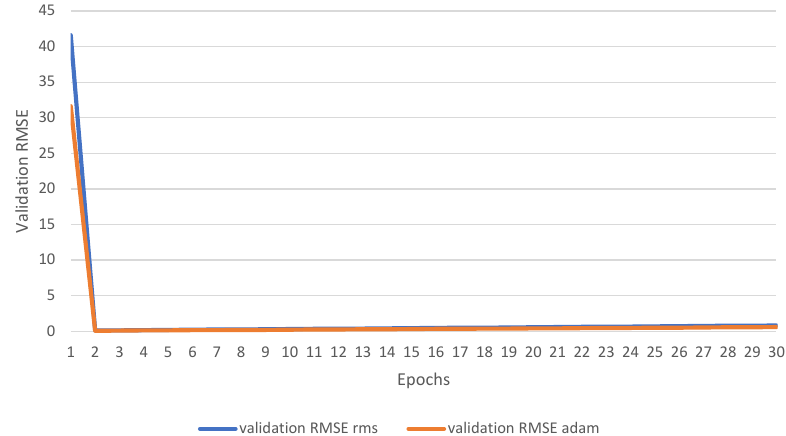
Figure 11. The proposed DCRN validation RMSE performance with SG layer based different opti- mizers.